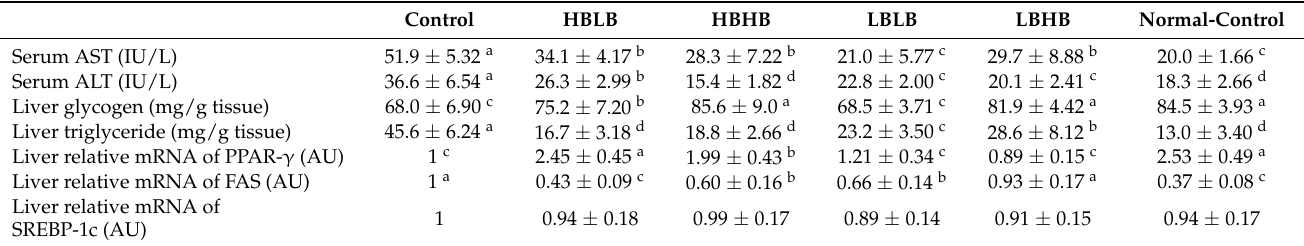
Table 4. Liver damage index and hepatic glucose and lipid metabolism.